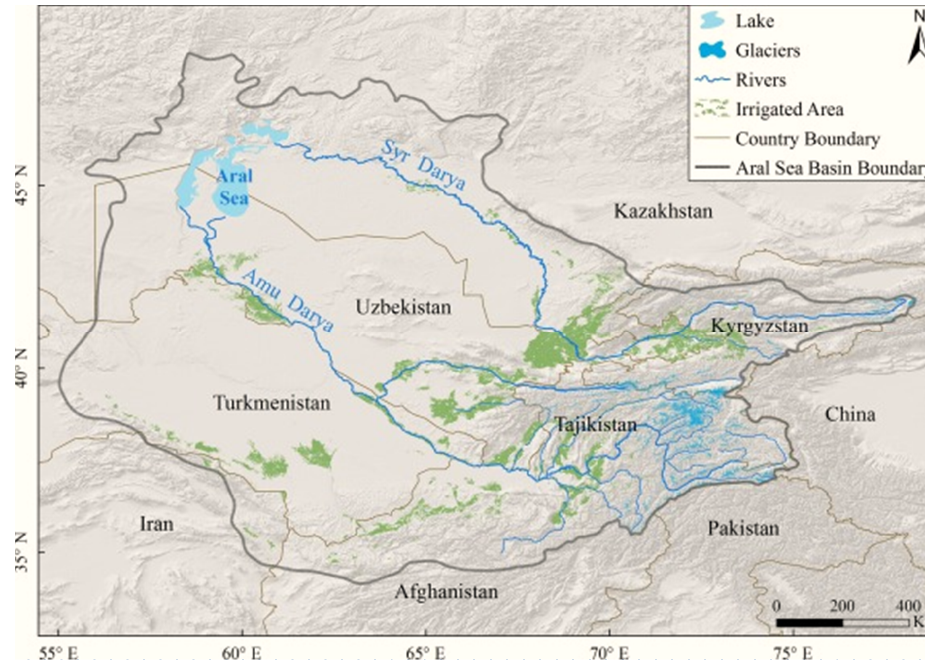
Figure 1. Location of the Aral Sea.